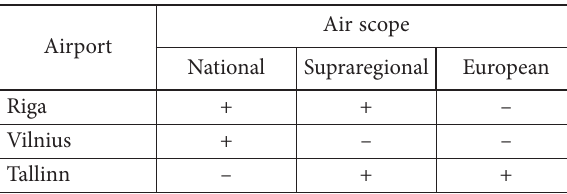
Table 7. Application of research findings on air